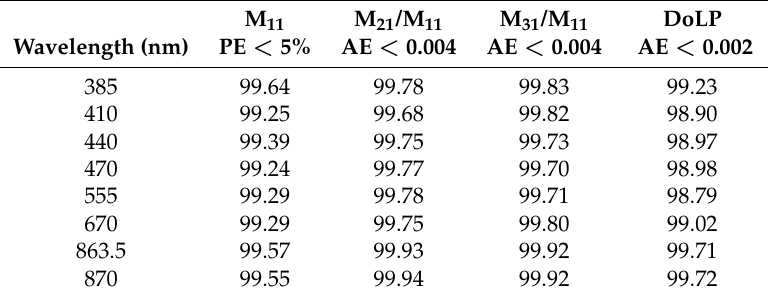
Table 2. Percentage of cases for element M 11 with Percentage error (PE) less than 5% and percentage of cases for elements M 21 /M 11 and M 31 /M 11 with Absolute error (AE) less than 0.004, and Degree Of Linear Polarization.